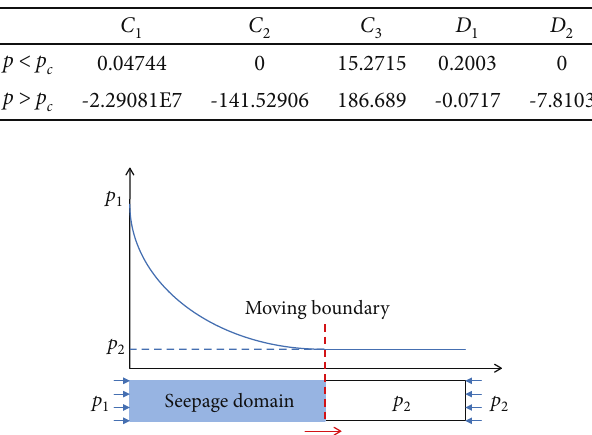
Figure 1: 1D seepage-controlled model with moving